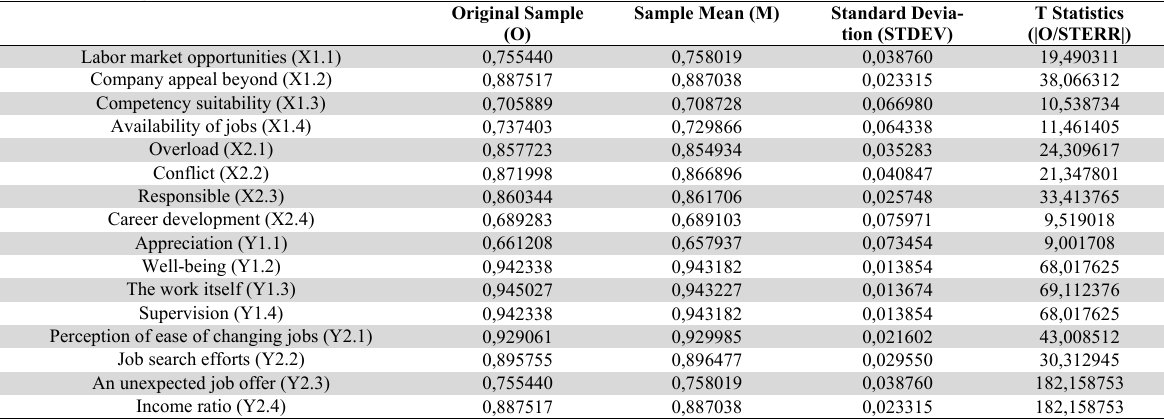
Original Sample Sample Mean (M) Standard Devia- (O)